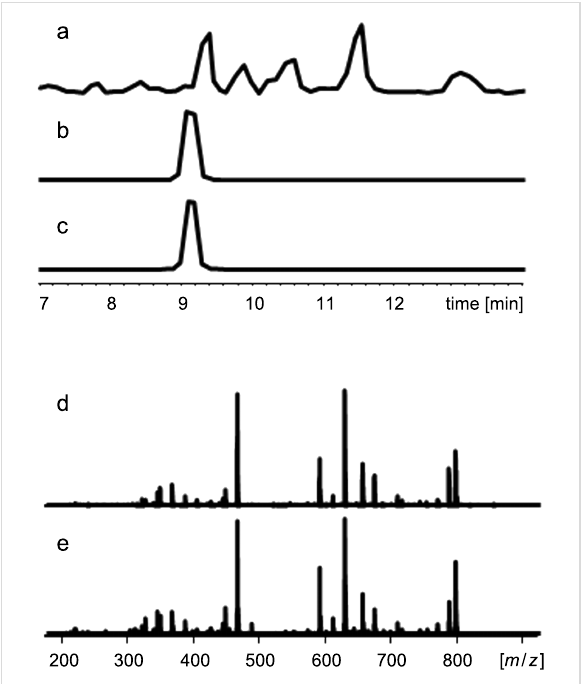
Figure 2: HPLC–MS data of an XAD-extract of X. szentirmaii (a; base- peak chromatogram), the natural 1 (b; extracted-ion chromatogram) and synthetic 1 (c; extracted-ion chromatogram) with their MS 2 -spectra (d, natural 1 , and e, synthetic 1